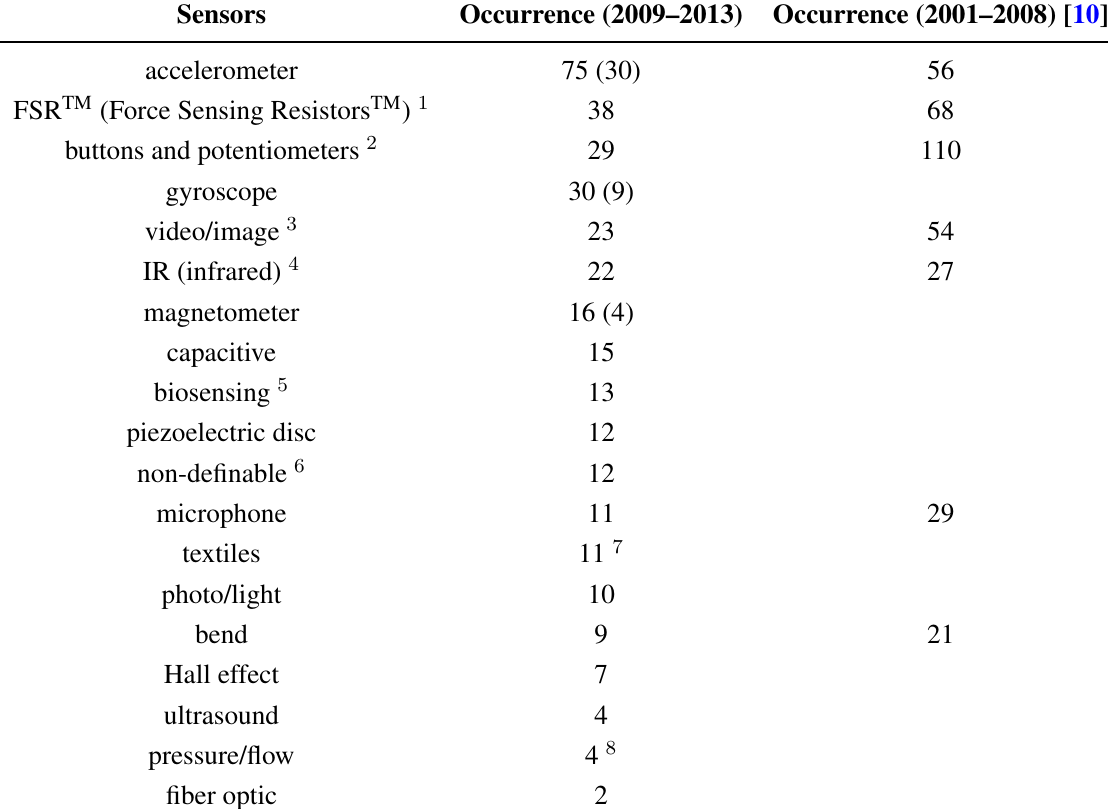
Dataset of sensor use in NIME conference proceedings from 2009 to 2013, compared with respective dataset of previous study [10]. MARG sensors have